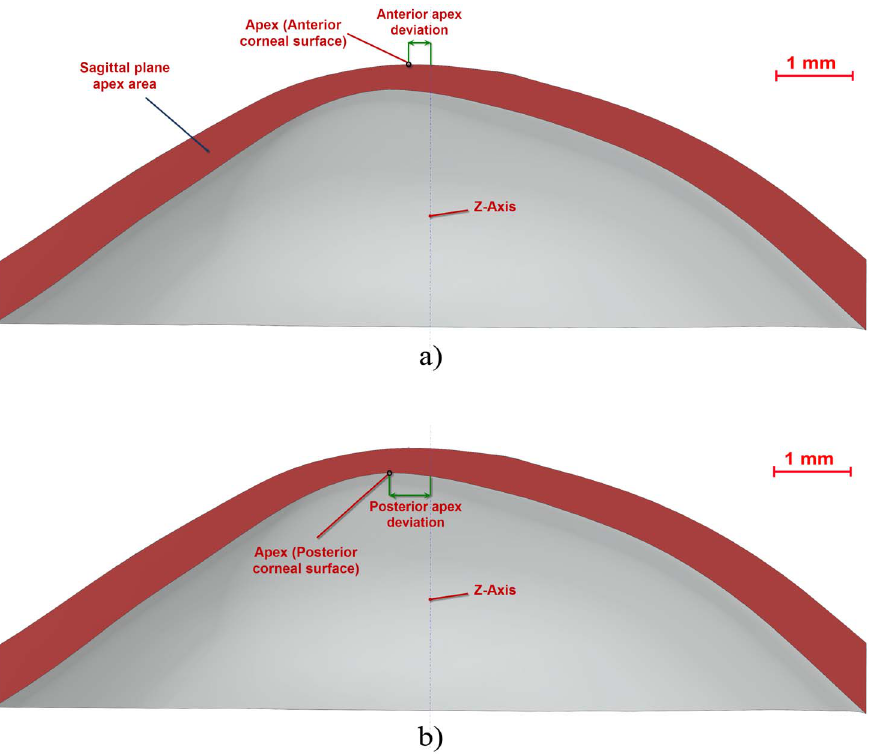
Figure 3. Sagittal plane of the cornea: a) passing through anterior apex and the Z-axis, b) passing through posterior apex and the Z-axis.